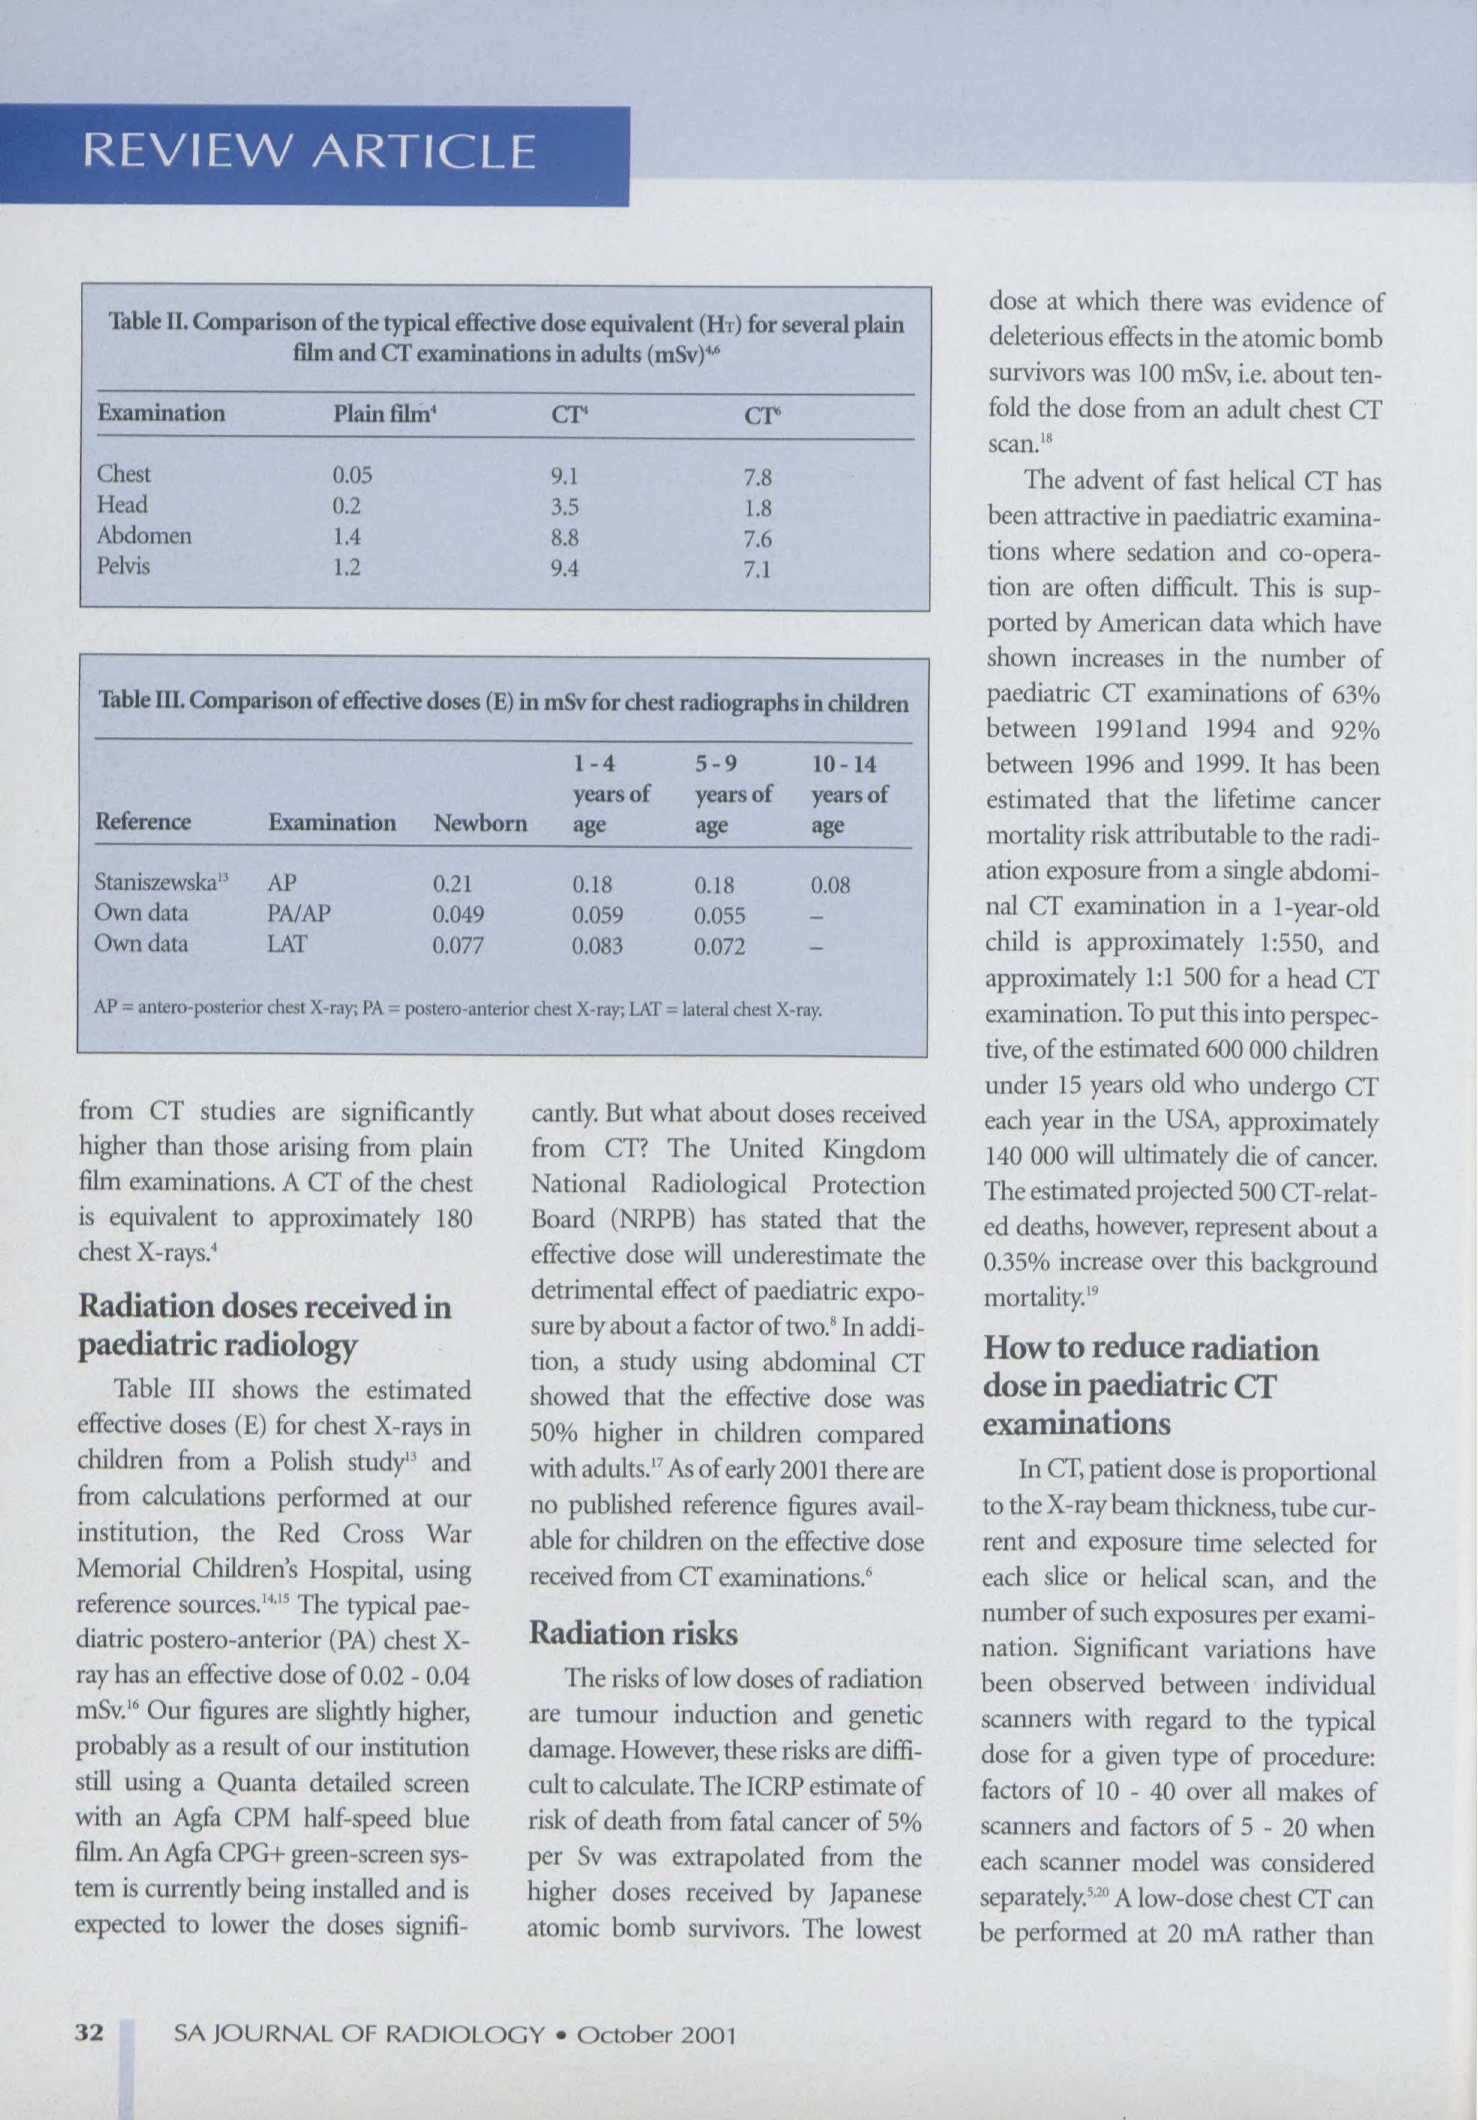
Table III. Comparison of effective doses (E) in mSv for chest radiographs in children